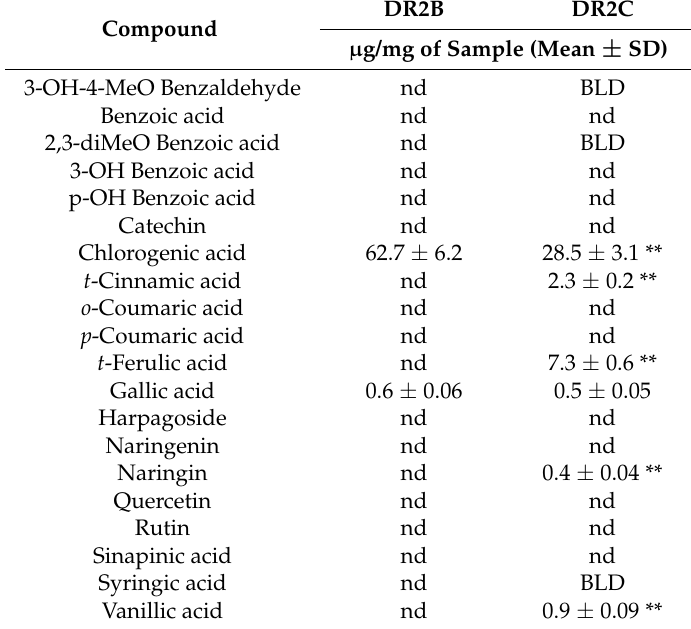
Table 3. Phenolic composition of DR2B and DR2C extracts by HPLC- PDA